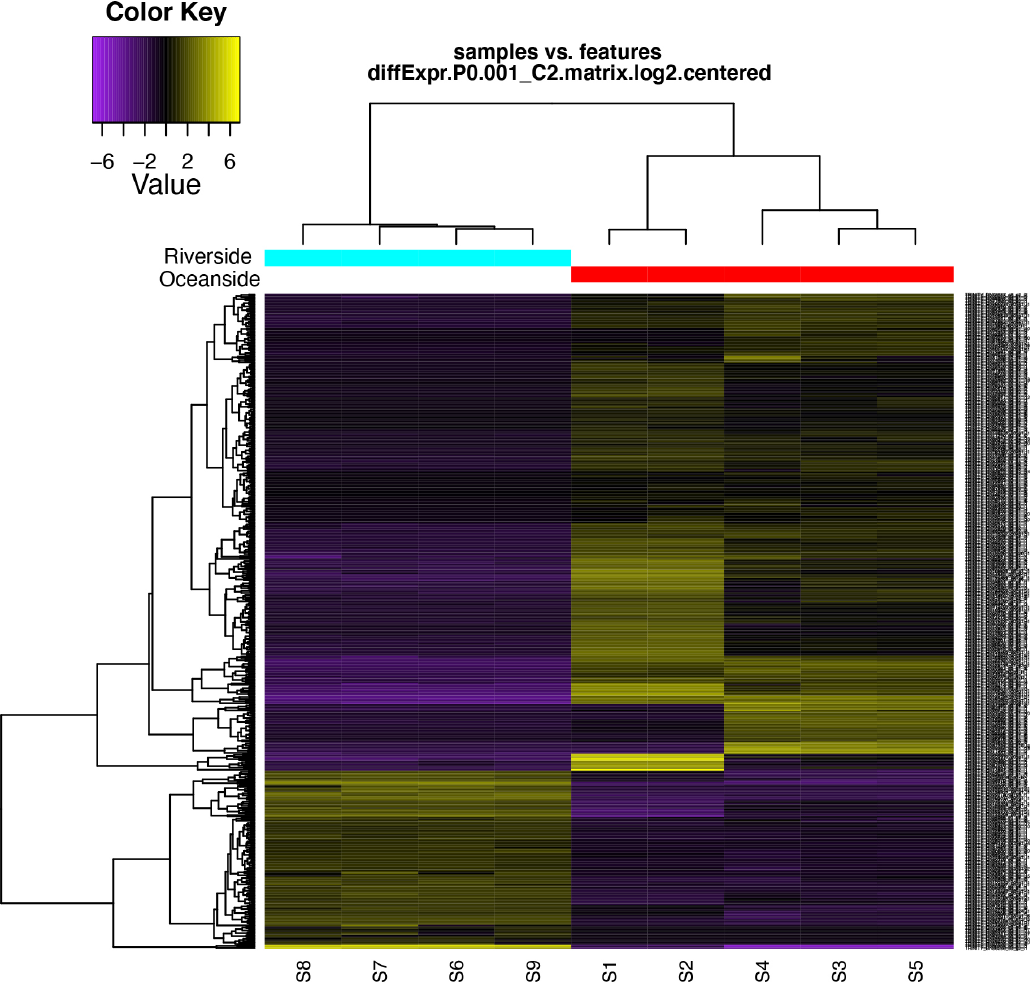
Figure 4. Hierarchical clustering of differentially expressed transcripts and oceanside-riverside B. gymnorhiza leaf samples. Heatmap showing the relative expression levels of each transcript (rows) in each sample (columns). Rows and columns are hierarchically clustered. Expression values (FPKM) are log 2 –transformed and then median-cantered by transcript. S1–S5 are the five replicates from the oceanside and S6–S9 are the four replicates from the riverside.